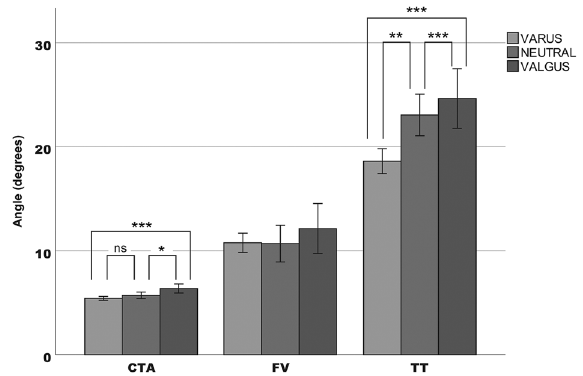
Figure 2. Comparison of rotational parameters among the groups divided by coronal alignment. The external Femoral Rotation and the external Tibial Torsion increased as the coronal alignment changed from varus to valgus. CTA condylar twist angle, FV Femoral Version, TT Tibial Torsion. *p < 0.05; **p < 0.001; ***p < 0.0005. ns no significant.